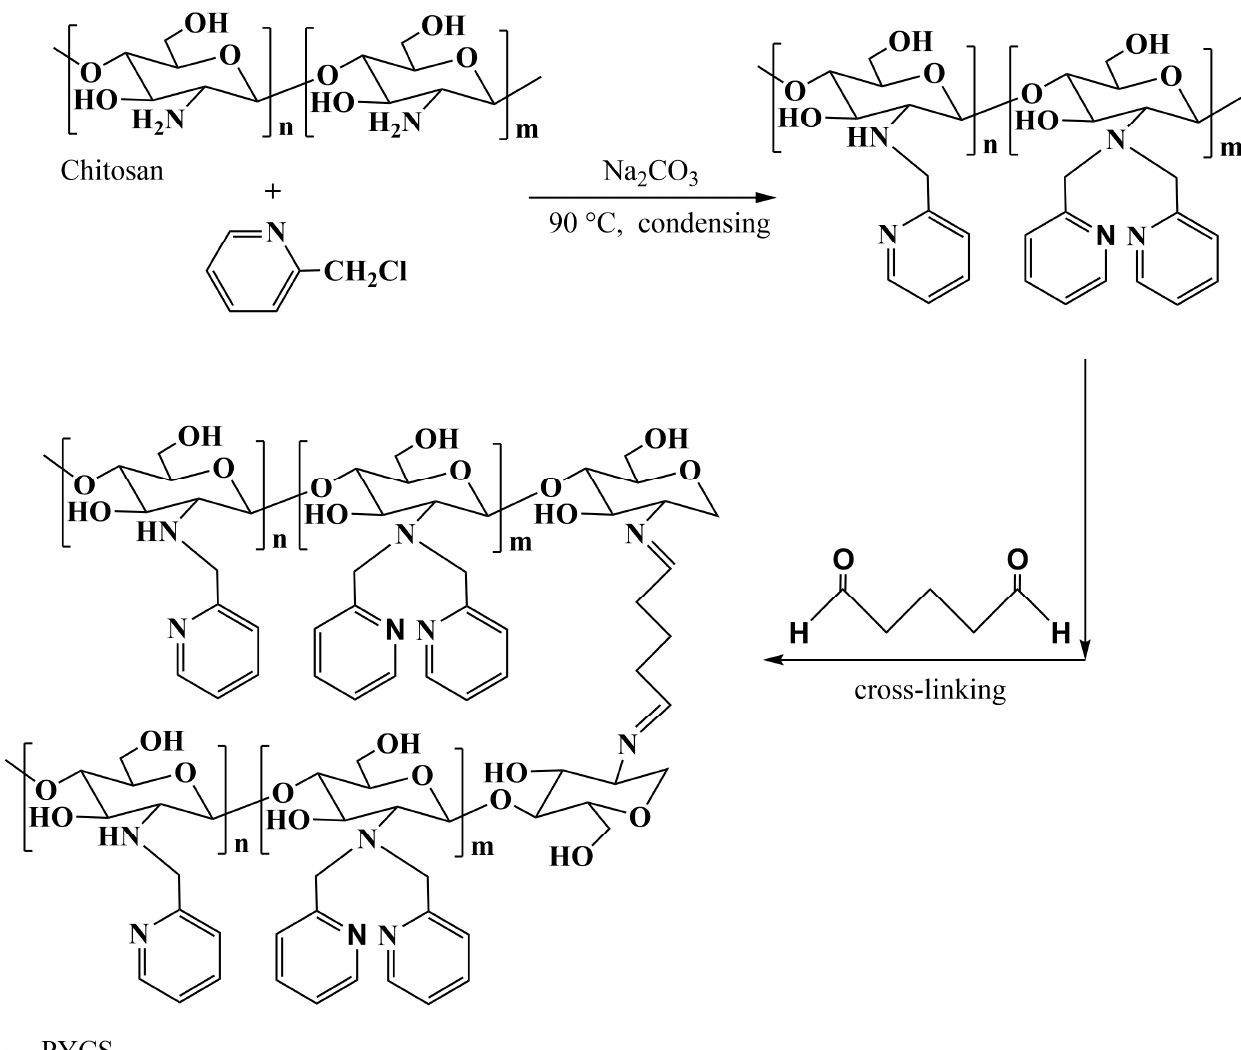
Figure 11. Synthetic procedure of PYCS.